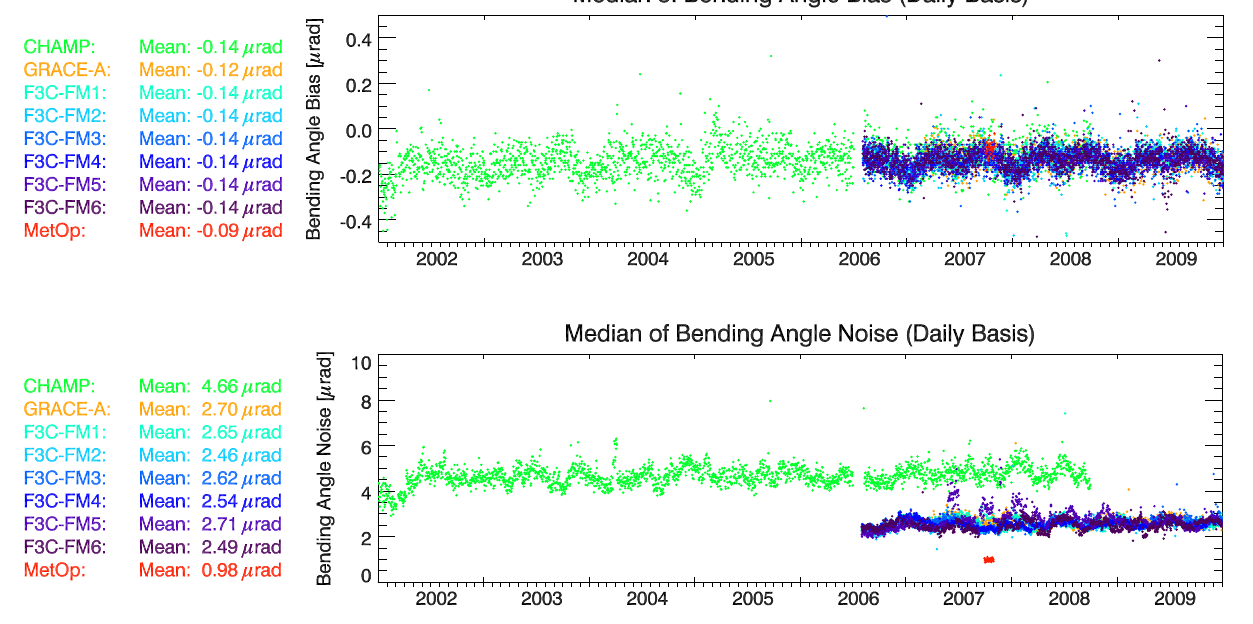
Fig. 1. Daily median bending angle bias with respect to the MSIS-E climatology (top) and daily median bending angle noise (bottom) for nine different satellites (listed left; showing also for each satellite the time-averaged mean value from its full period of observations). annual and semi-annual cycles with respect to MSIS-E. The mean value for MetOp/GRAS ( − 0.09 µrad) refers only to October 2007, where the semi-annual cycle shows a maxi- mum. The value is therefore also consistent with those from the other